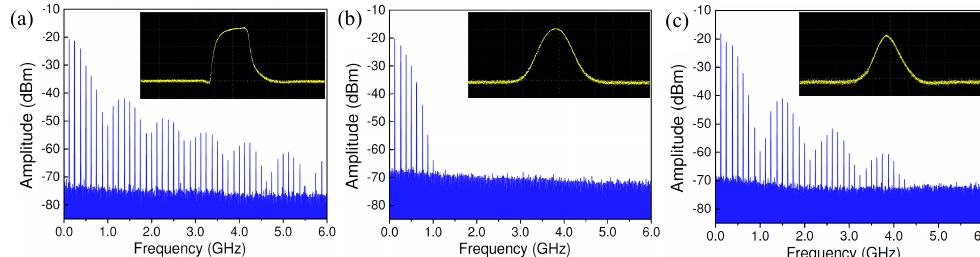
Figure 13. Demonstration of the pulse shaping function based on the proposed RF equalizer. ( a ) RF spectrum of a square-like pulse that to be reshaped. ( b ) Reshaped into a Gaussian pulse through the low-pass equalization function. ( c ) Reshaped into a triangular pulse trough the saw-tooth equalization function. Insets: Waveforms of the corresponding pulses in time domain.